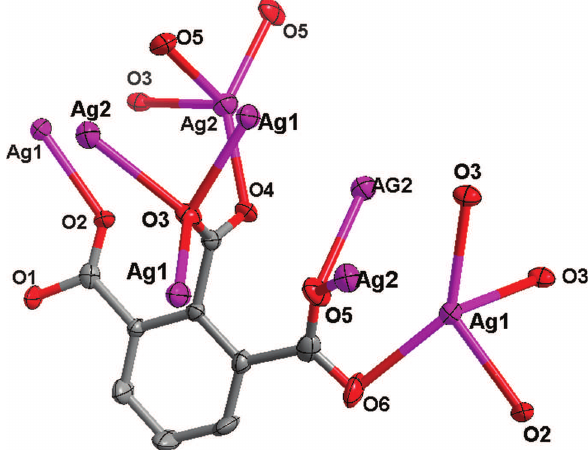
Table 1: Data collection and handling.